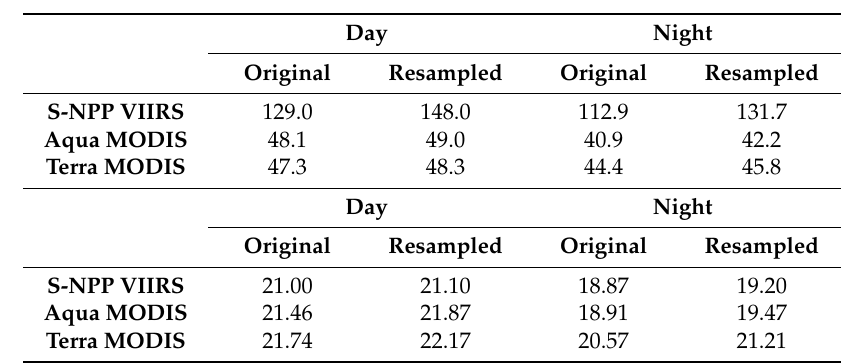
Table 1. Top: Number of clear-sky ocean pixels, CN (millions). Down: Corresponding clear-sky fraction, CF (percent to total number of ocean pixels observed by the corresponding sensor). Data are from one full global day on 18 October